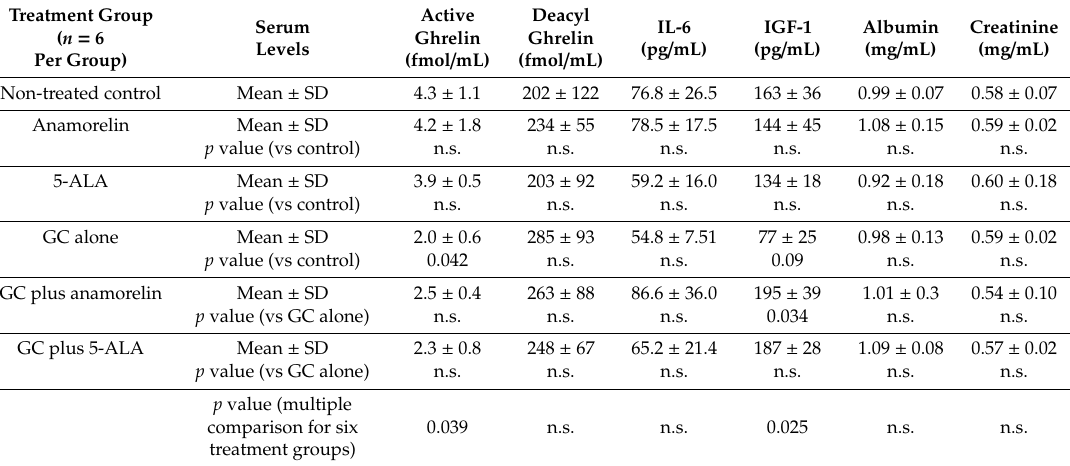
Table 4. Comparison of post-treatment serum biomarkers among the treatment